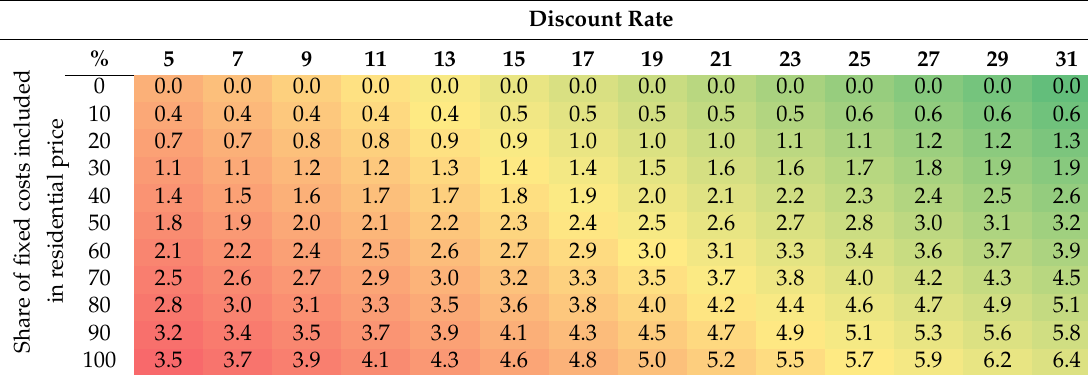
Table 6. Nonresident blocking tari ff rate in EUR / night.